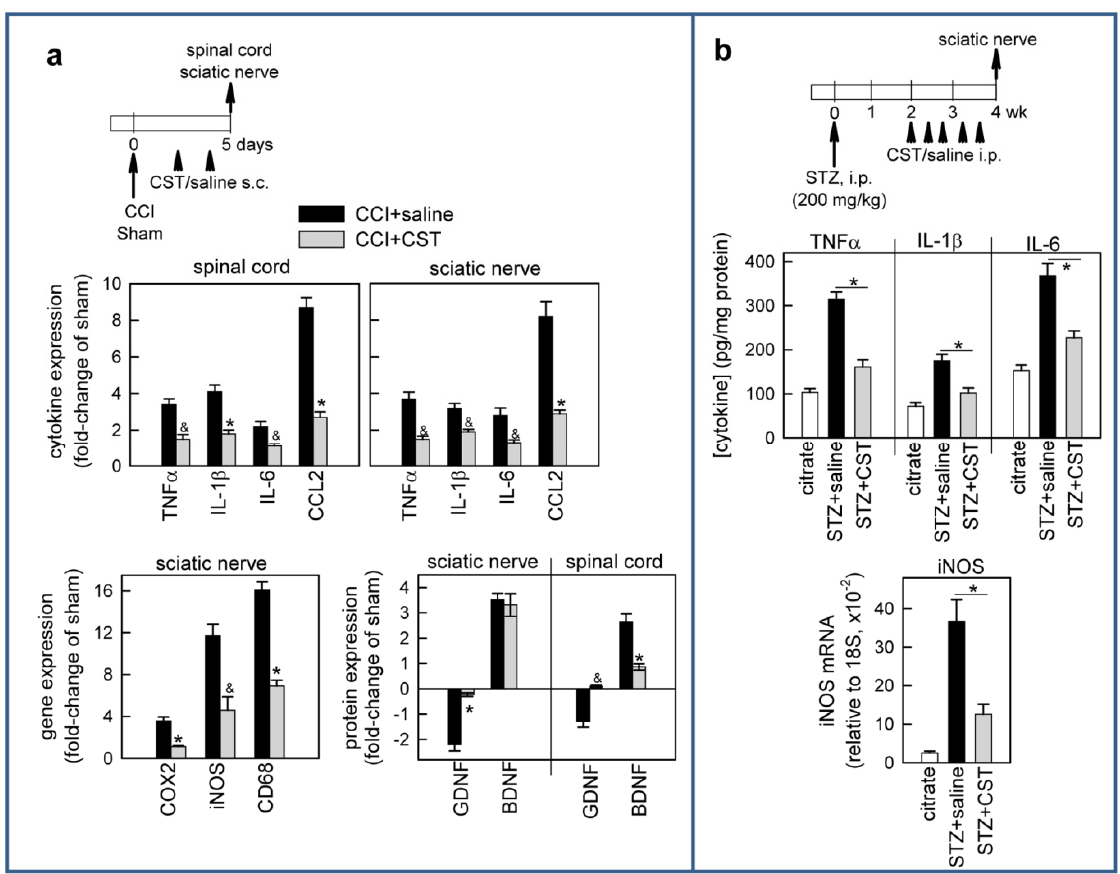
Figure 5. Treatment with cortistatin regulated neuroinflammation and neurotrophic factors in nocifensive system after peripheral nerve injury. ( a ) Effects of cortistatin (1 µg, injected s.c. around the injured nerve, as indicated in scheme) on the contents of cytokines, chemokines, and neurotrophic factors in protein extracts and on gene expression of COX2 and iNOS in mRNA isolated from ipsilateral sciatic nerve and L4-L5 dorsal spinal cord segments dissected at day 5. The presence of macrophages in the sciatic nerve was determined by measuring the expression of CD68. Results were referenced to samples obtained from sham-operated mice. n = 6 mice/group, pooled in three samples. * p < 0.0001 versus saline-treated CCI mice. ( b ) Effects of cortistatin (2 µg, injected i.p., as indicated in scheme) on cytokine contents in protein extracts and on iNOS gene expression in mRNA isolated from sciatic nerves four weeks after injection of streptozotocin (STZ). Nondiabetic mice (citrate) were used as controls of reference. n = 8 mice/group. * p < 0.0001 versus saline-treated STZ-diabetic mice. All data represent mean ± SEM.